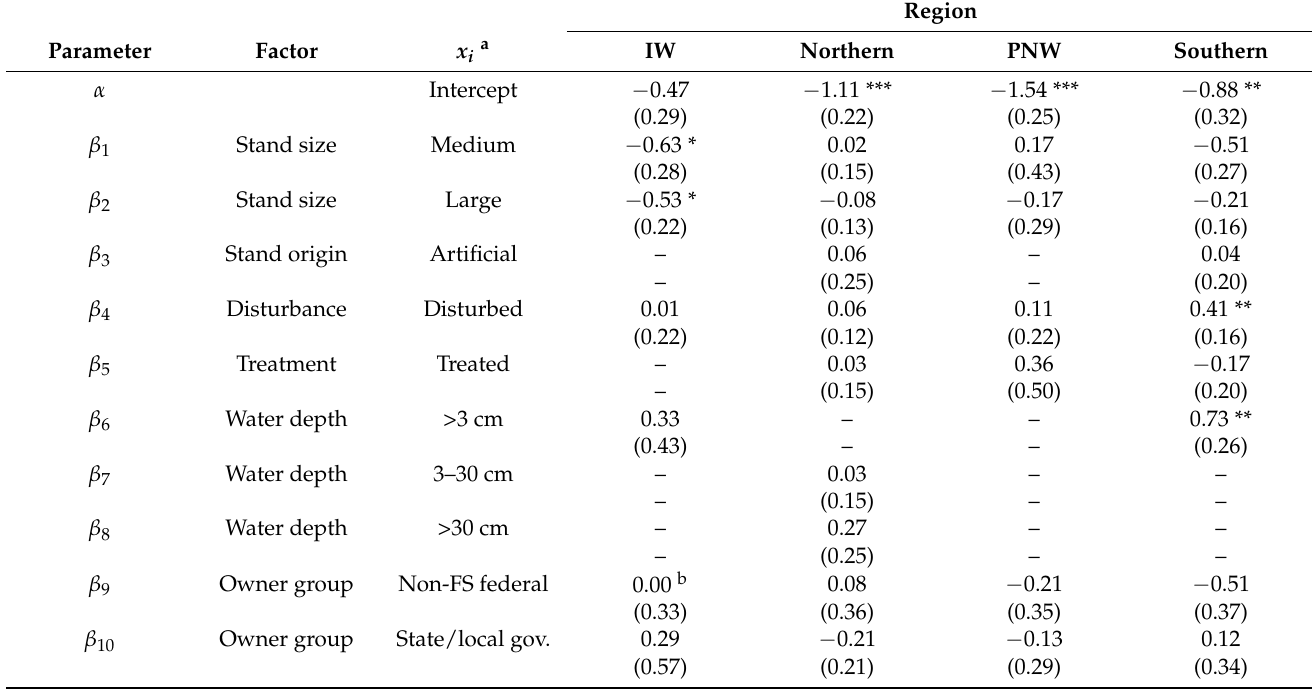
𝑥 + 𝛽 𝑥 + (cid:2869) (cid:2869) (cid:2870) (cid:2870)